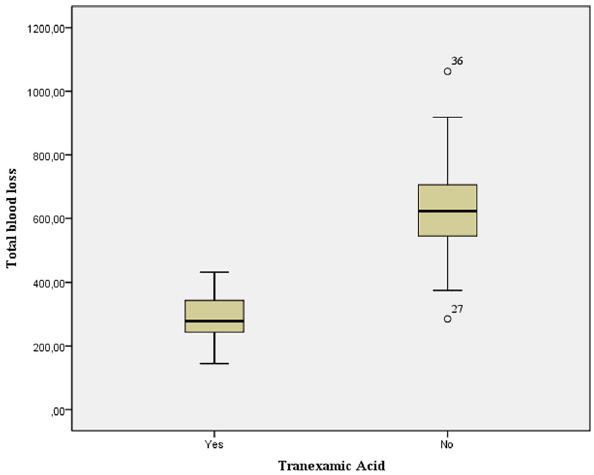
Figure 3: Total blood loss in the analyzed